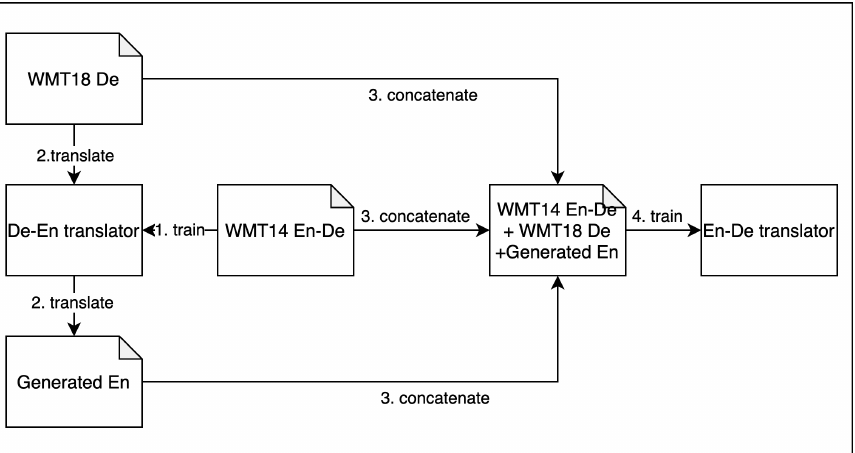
Figure 1. Back-translation is a method that uses additional data to improve translation performance. There are four major steps in the learning process. In recent years, it has begun to be used to evaluate state of the art models. This research is based on